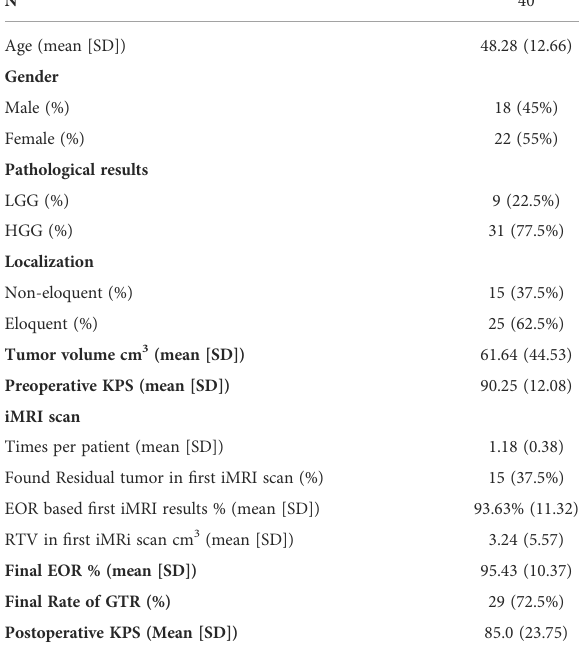
TABLE 1 Pre- and intra-operative data and surgical